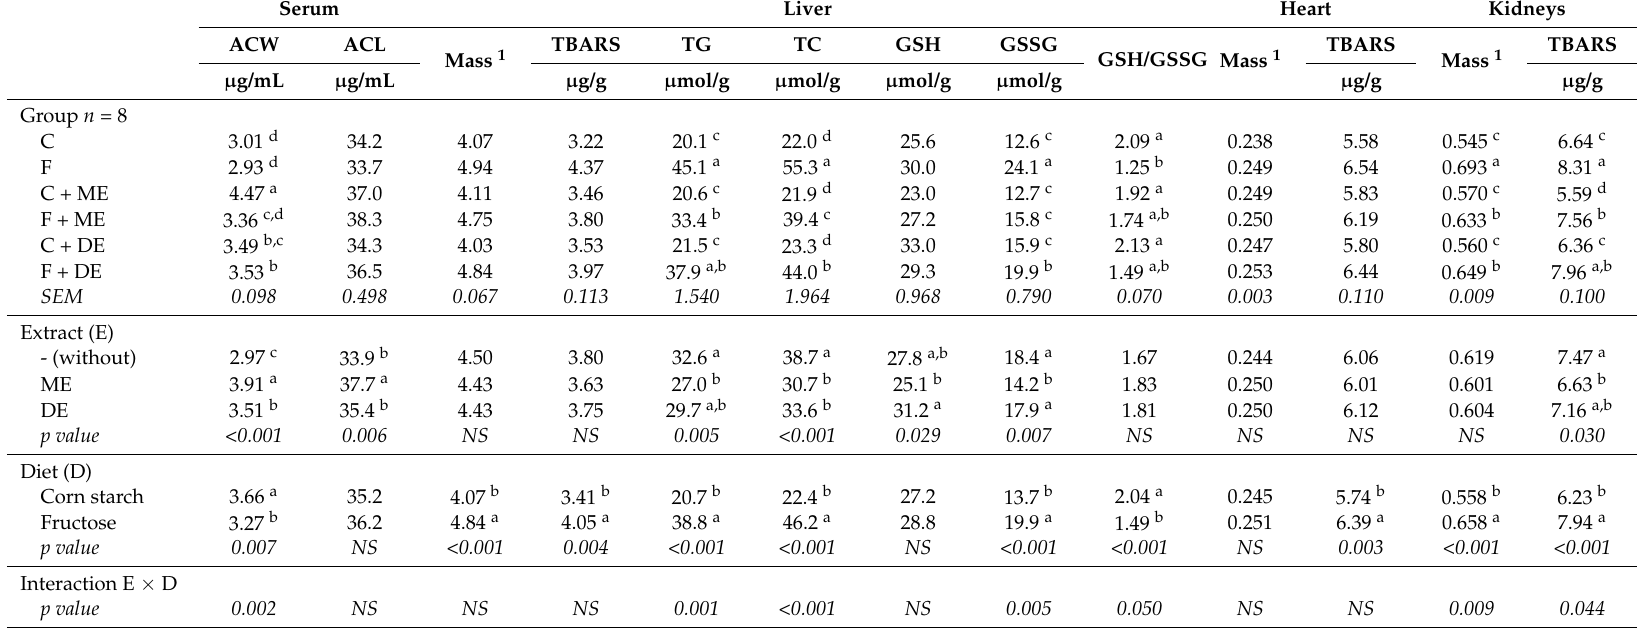
Table 9. Antioxidant status indices of rats fed experimental diets